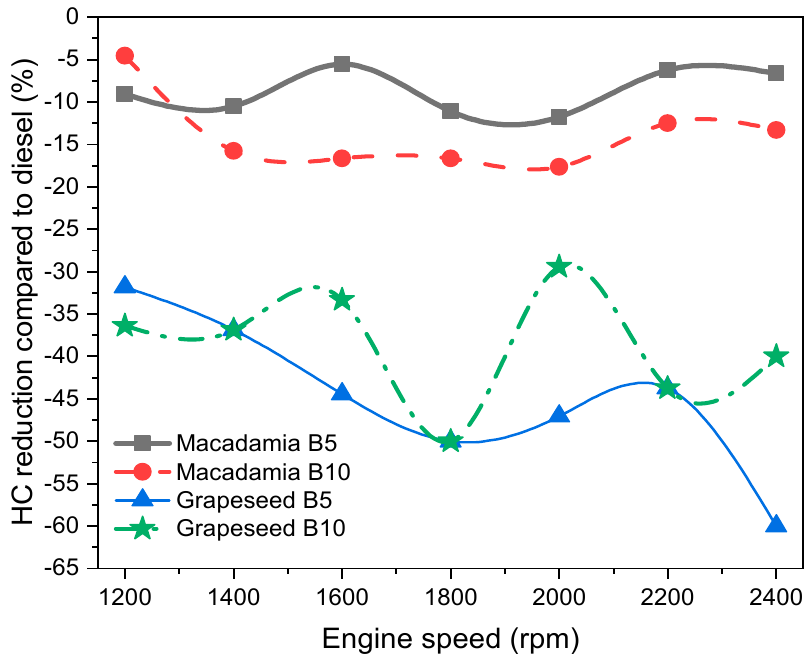
Figure 7. Hydrocarbon (HC) emission reduction compared to diesel using B5 and B10 biodiesel blends. The t -test indicates HC reductions are statistically significant ( p -value < 0.05) as indicated by the p -value of 0.022 for Macadamia B5 vs. B10; the p -value of 0.0001 for both B5 and B10 blends